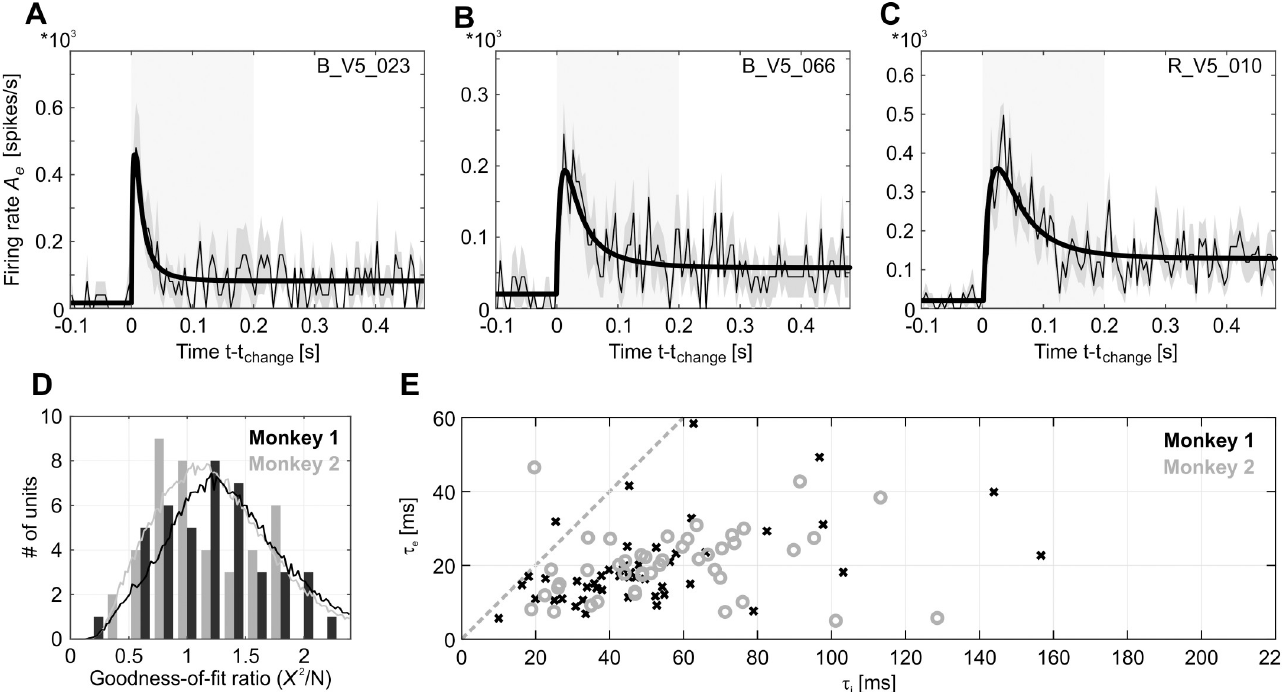
Fig 2. Model fits to stimulus onset transients. (A–C) Activity of three example multi-units (thin lines) and corresponding model fit (solid lines). Gray shading indicates standard error over 5–10 trial repetitions, light gray box indicates fitting interval. Time axis is shown relative to neural response onset. Note that actual responses were not smoothed for visual purposes. (D) Model Chi-square distributions of the recorded units for two monkeys (M1, black bars; M2, gray bars). Solid lines show surrogate data distributions for artificially generated spike data from models with known parameters (M1, black; M2, gray). (E) Scatter plot for fitted time scales τ e versus τ i (M1, crosses; M2, open